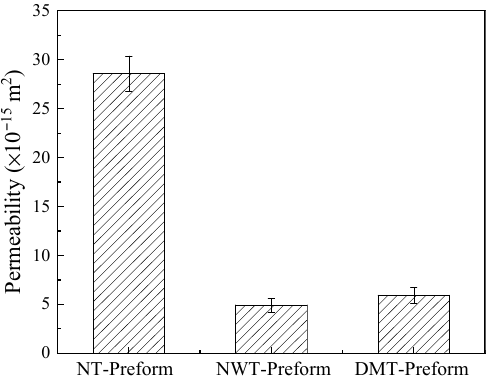
Figure 8. Effects of the toughening agent structures on the z-directional permeability of the pre- forms.